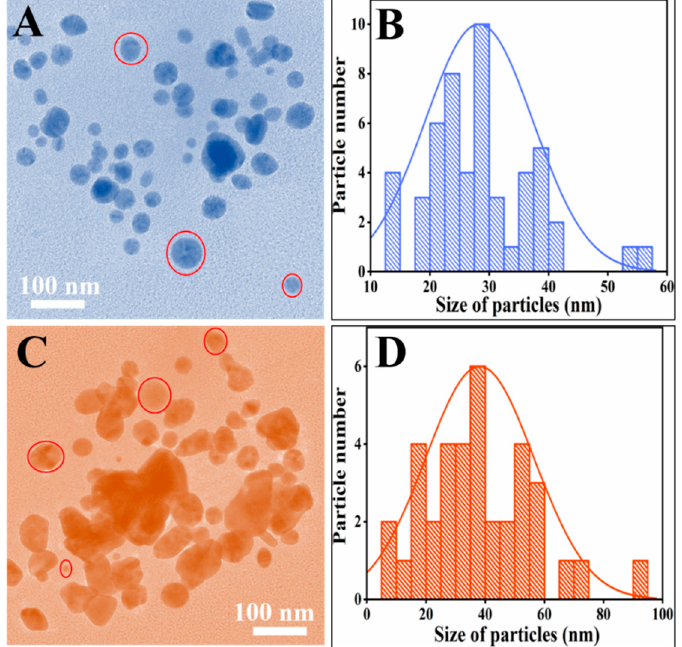
Figure 4. TEM micrographs of ( A ) R-Ag-NPs and ( B ) L-Ag-NPs and their relative particles size distribution histogram ( C , D